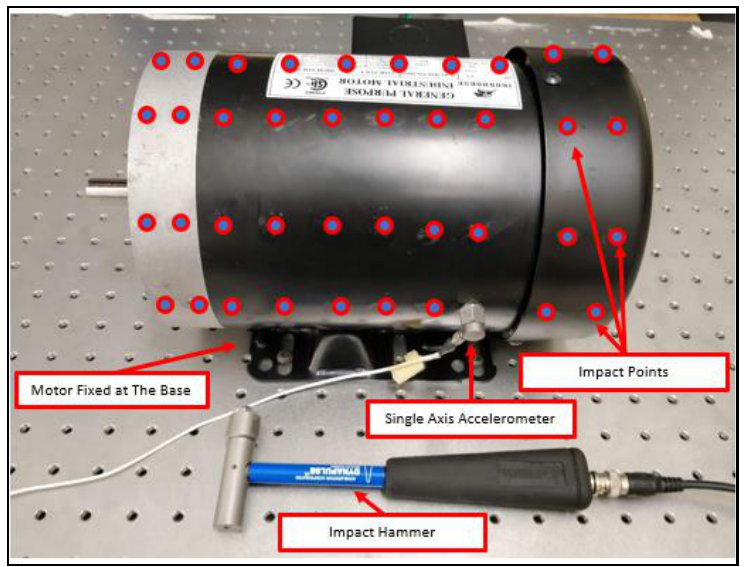
Figure 1. EMA test setup using the impact hammer technique on a motor fixed to the base.